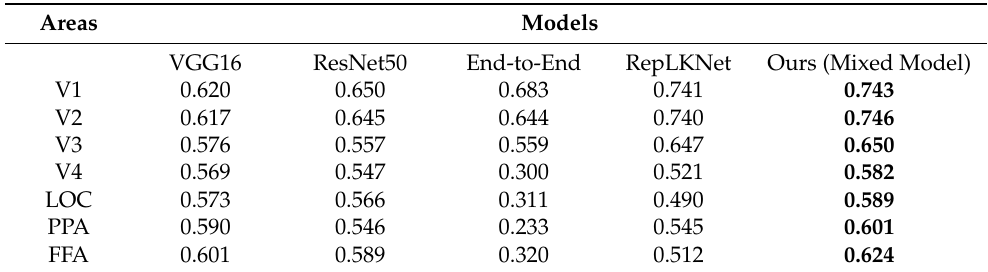
Table 2. The ROI-level encoding performance of VGG16, ResNet50, End-to-End, and our models of subject 3. Bold fonts mark our data